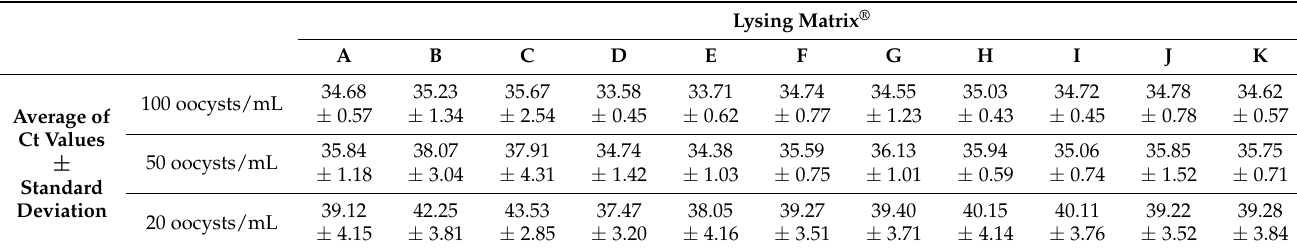
Table 4. Average of Ct values and standard deviations of PCR results according to the mechanical lysing matrix and oocyst